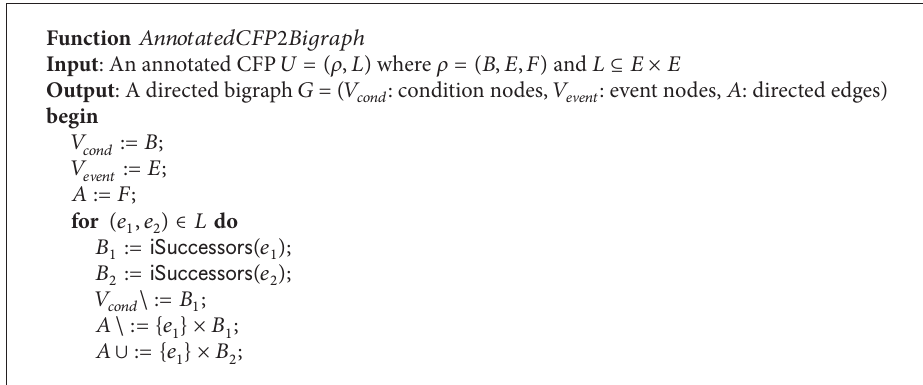
Function 𝐴𝑛𝑛𝑜𝑡𝑎𝑡𝑒𝑑𝐶𝐹𝑃2𝐵𝑖𝑔𝑟𝑎𝑝ℎ